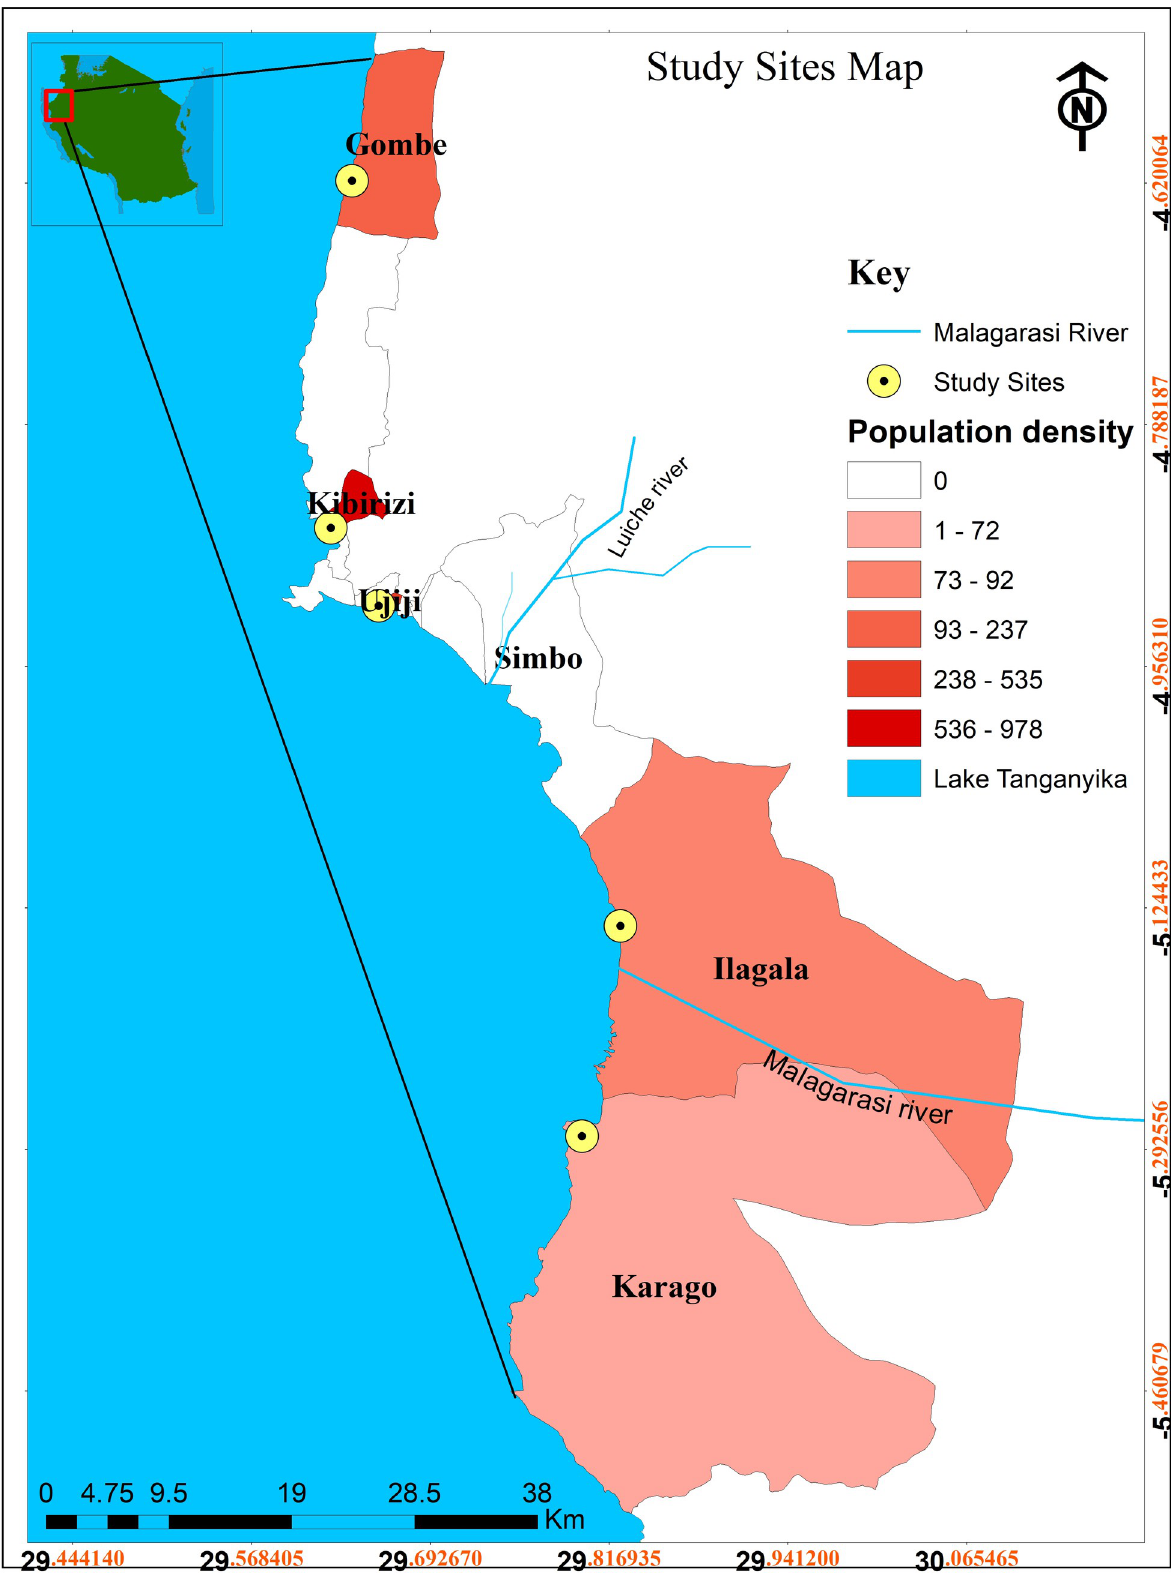
Fig 1. A map of Lake Tanganyika showing study sites. https://doi.org/10.1371/journal.pone.0262881.g001 PLOS ONE | https://doi.org/10.1371/journal.pone.0262881 January 28,